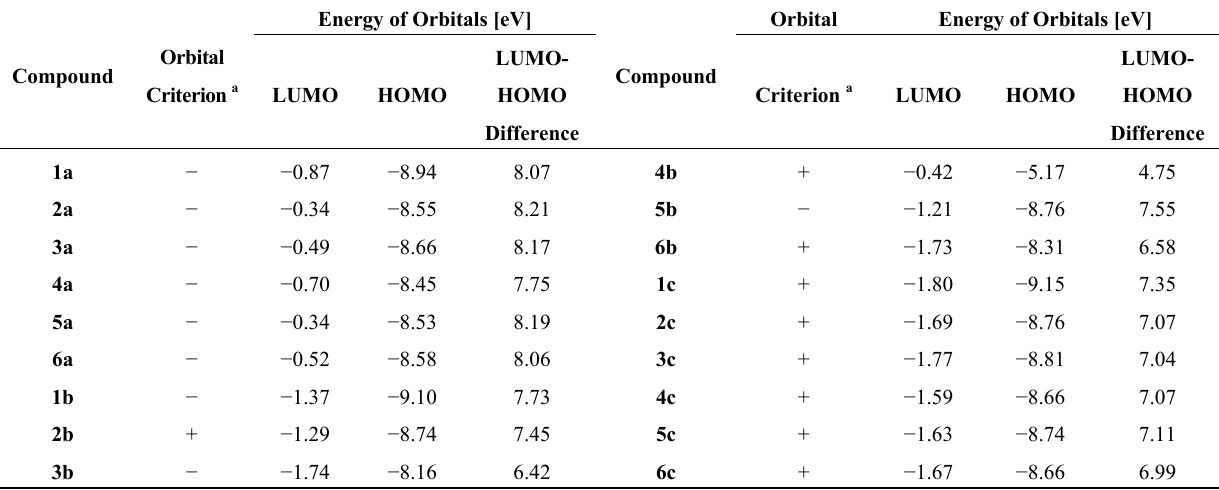
Table 2. Characteristics of LUMO and HOMO energies for selected